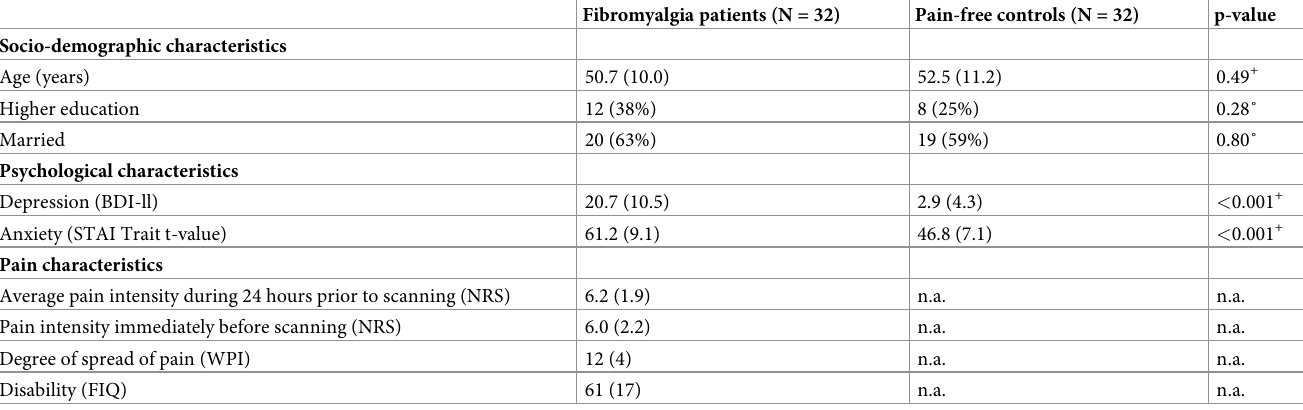
Table 1. Baseline characteristics of fibromyalgia patients and pain-free